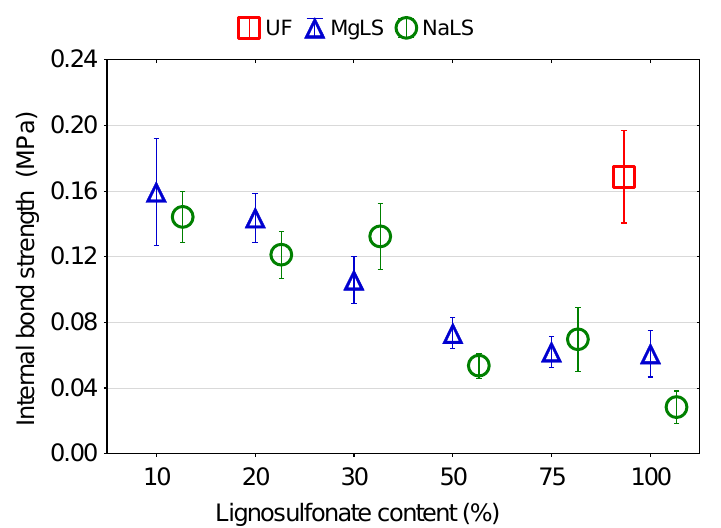
Figure 7. The internal bond (IB) strength of boards made with lignosulfonated-urea-formaldehyde adhesive.